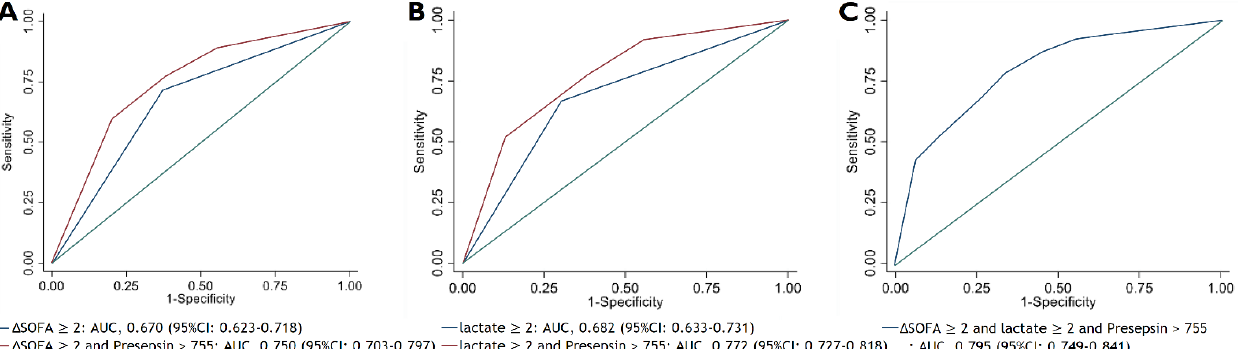
Figure 5. Area under the curve (AUC) of the receiver operating characteristic (ROC) curves of ( A ) delta SOFA score ≥ 2 points and combination model with high presepsin, ( B ) lactate ≥ 2 mmol/L and combination model with high presepsin, and ( C ) combination model of delta SOFA score ≥ 2, lactate ≥ 2 mmol/L, and presepsin. High presepsin was defined as a presepsin level greater than 755 pg/mL.